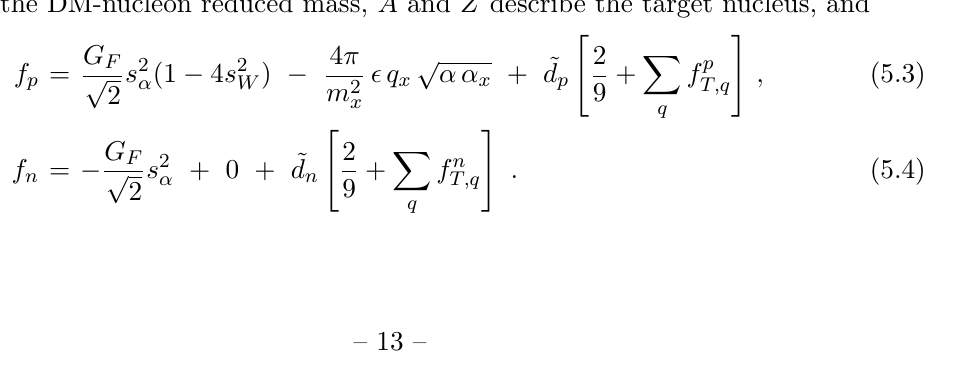
c , and include W W , (cid:11) (cid:11)